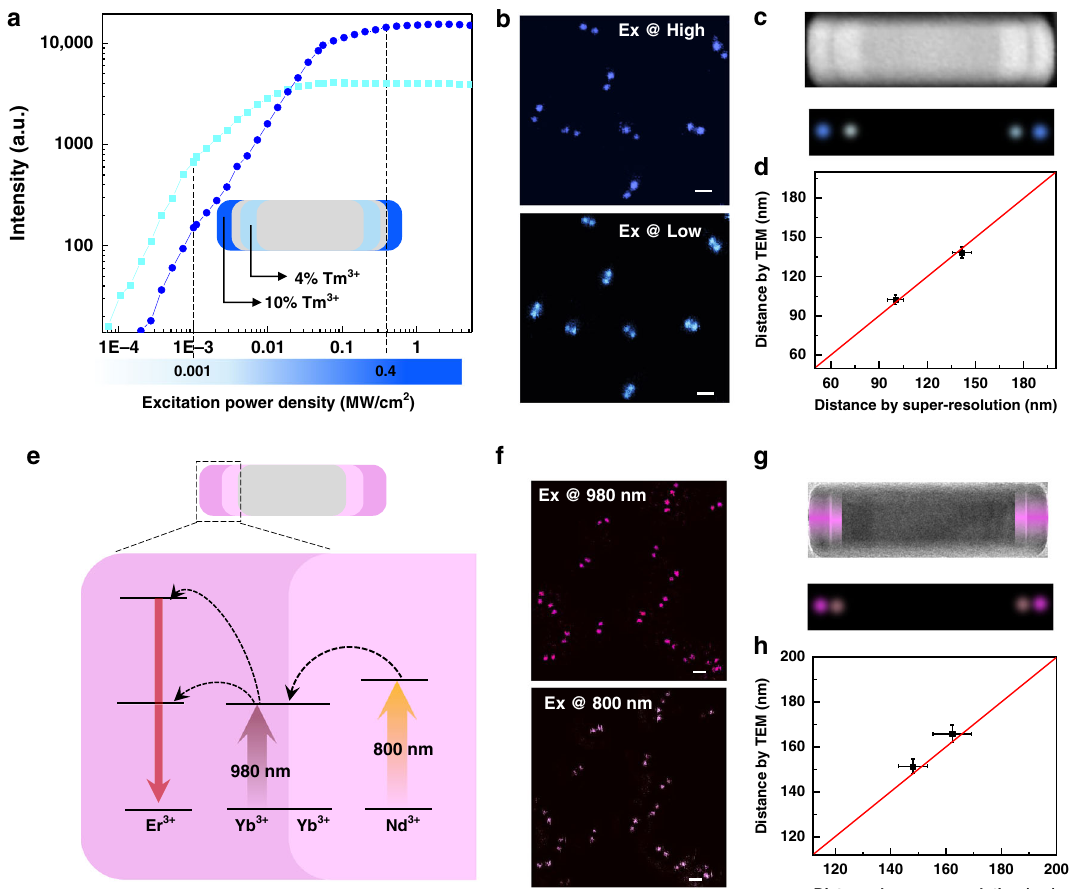
Fig. 3 Super-resolution decoding nanorods with different optical dimensions. a The scheme using the excitation-power-dependent property to activate the different segments of a purpose-designed nanorod. The upconversion emissions, generated from the segment doped with relatively higher concentration (10% Tm 3 + ), can be turned on at higher excitation power density, compared with that from lower doped (4% Tm 3 + ) segments. b Super- resolution images of the functional segments selectively decoded by high and low power density conditions. c HAADF-STEM image and corresponding two-channel super-resolution image. d Statistical analysis of the distance distributions of different sections measured by TEM images and super-resolution images, data are shown as the mean ± SD. e The scheme using the long-distance energy migration property to activate the nearby segments for decoding the location of different sensitizers. f Super-resolution images of the functional segments selectively decoded by 980 nm and 808 nm excitation. g TEM image and corresponding two excitation-wavelength-channel super-resolution images. h Statistical analysis of the distance distributions of different sections measured by TEM images and super-resolution images, data are shown as the mean ± SD. Pixel sizes in b and f are 10 nm. Scale bars are 200 nm. High-resolution images of b and f are shown in Supplementary Fig.